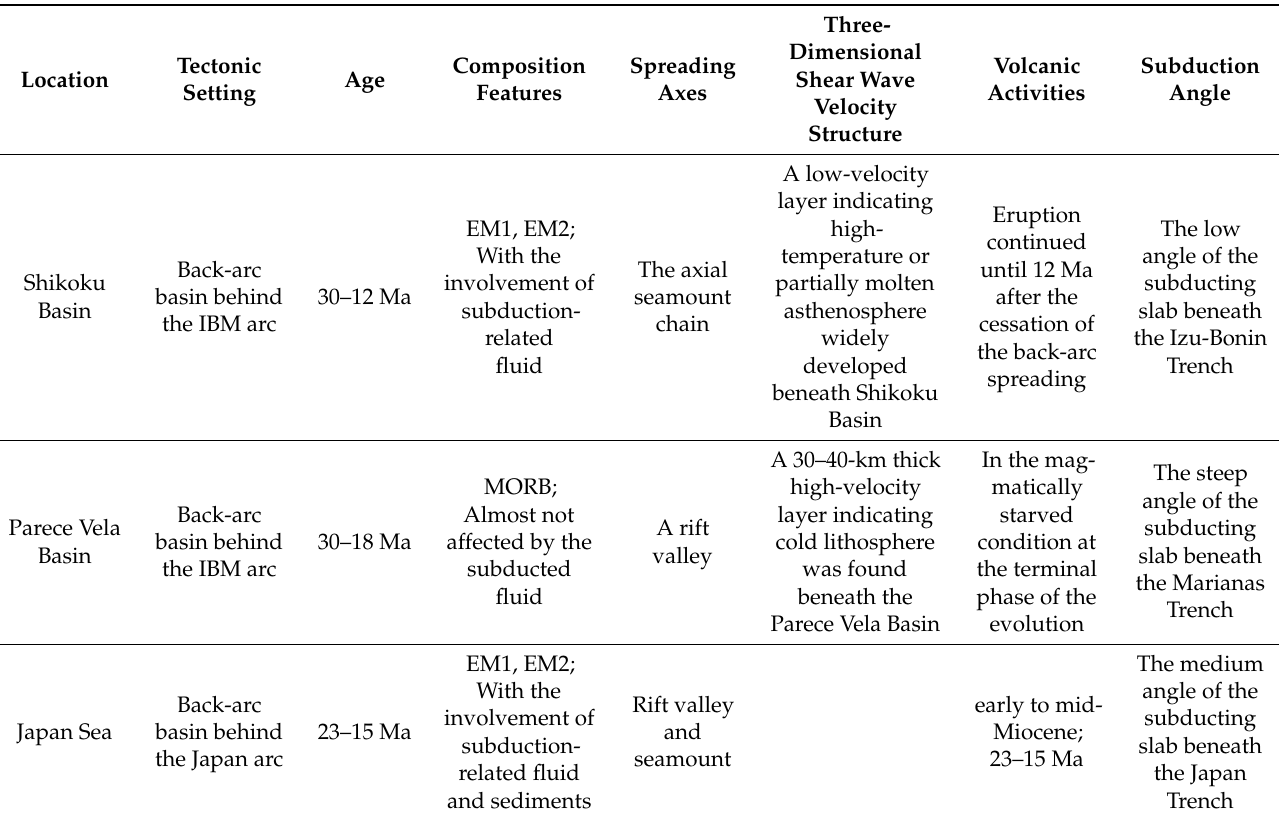
Table 5. The comparative features of the Shikoku Basin, Parece Vela Basin, and Japan Sea.